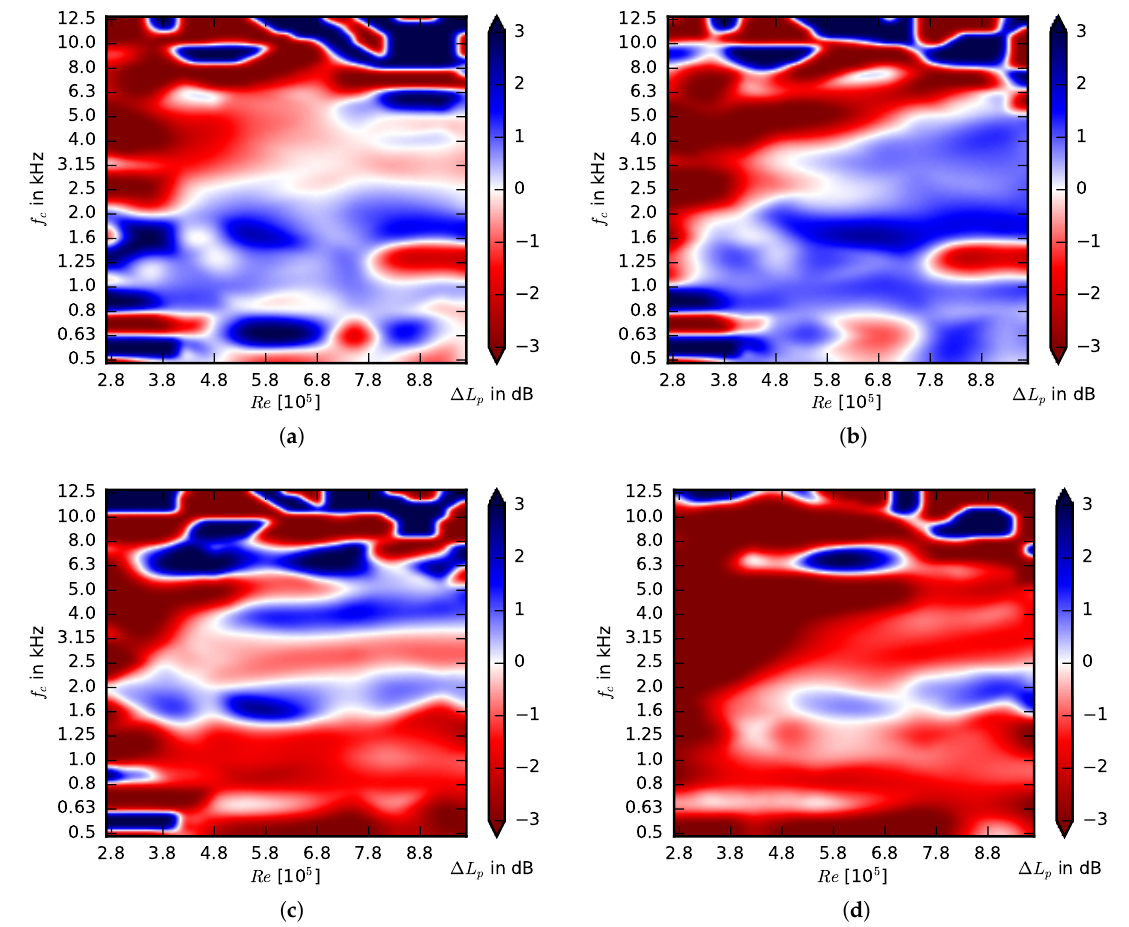
Figure 11. Leading edge sound pressure level difference ∆ L p according to Equation (4) for the airfoils with teeth of h / c l = 0.1, angle of attack 6 ◦ , PPS 12/2 turbulence grid (positive values denote a noise reduction due to the modifications, negative values a noise increase), ( a ) airfoil 1, h / c l = 0.1, s / c l = 0.038, straight, ( b ) airfoil 8, h / c l = 0.1, s / c l = 0.038, curved, ( c ) airfoil 3, h / c l = 0.1, s / c l = 0.019,